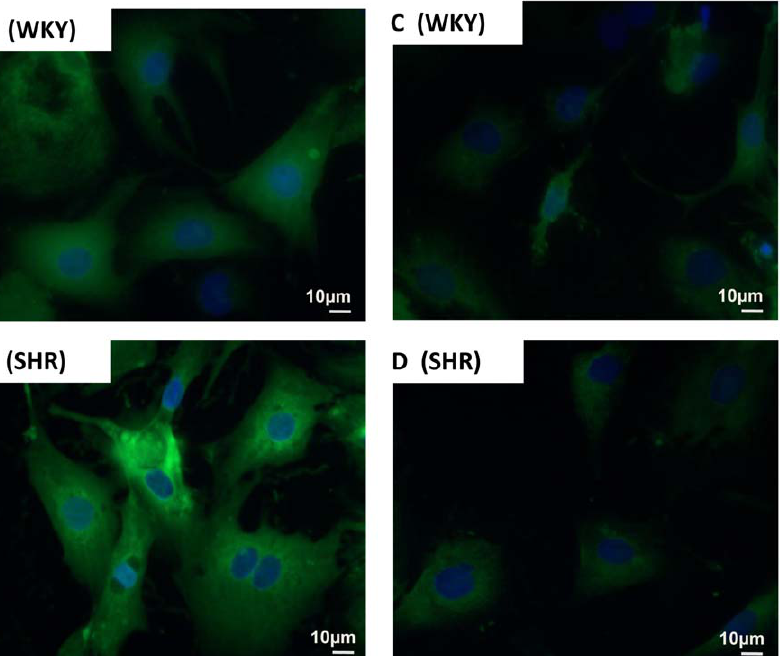
Figure 5. Characteristics of Ang-(1–12) expression in cultured myocytes. Representative examples of fluorescent photomicrographs of Ang- (1–12) immunoreactivity of the cultured myocytes (maintained for 48 hours in serum-deprived medium) from WKY (A and C; top panel ) and SHR (B and D; bottom panel ) with protein A purified Ang-(1–12) polyclonal antibody (1:100 dilution). (A and B) represents the fluorescent staining of endogenous Ang-(1–12) with antibody while (C and D) illustrates the blocking of fluorescent staining of cardiac myocytes after preadsorption of the antibody with 10 m M of synthetic rat Ang-(1–12) peptide. Magnification, X400.